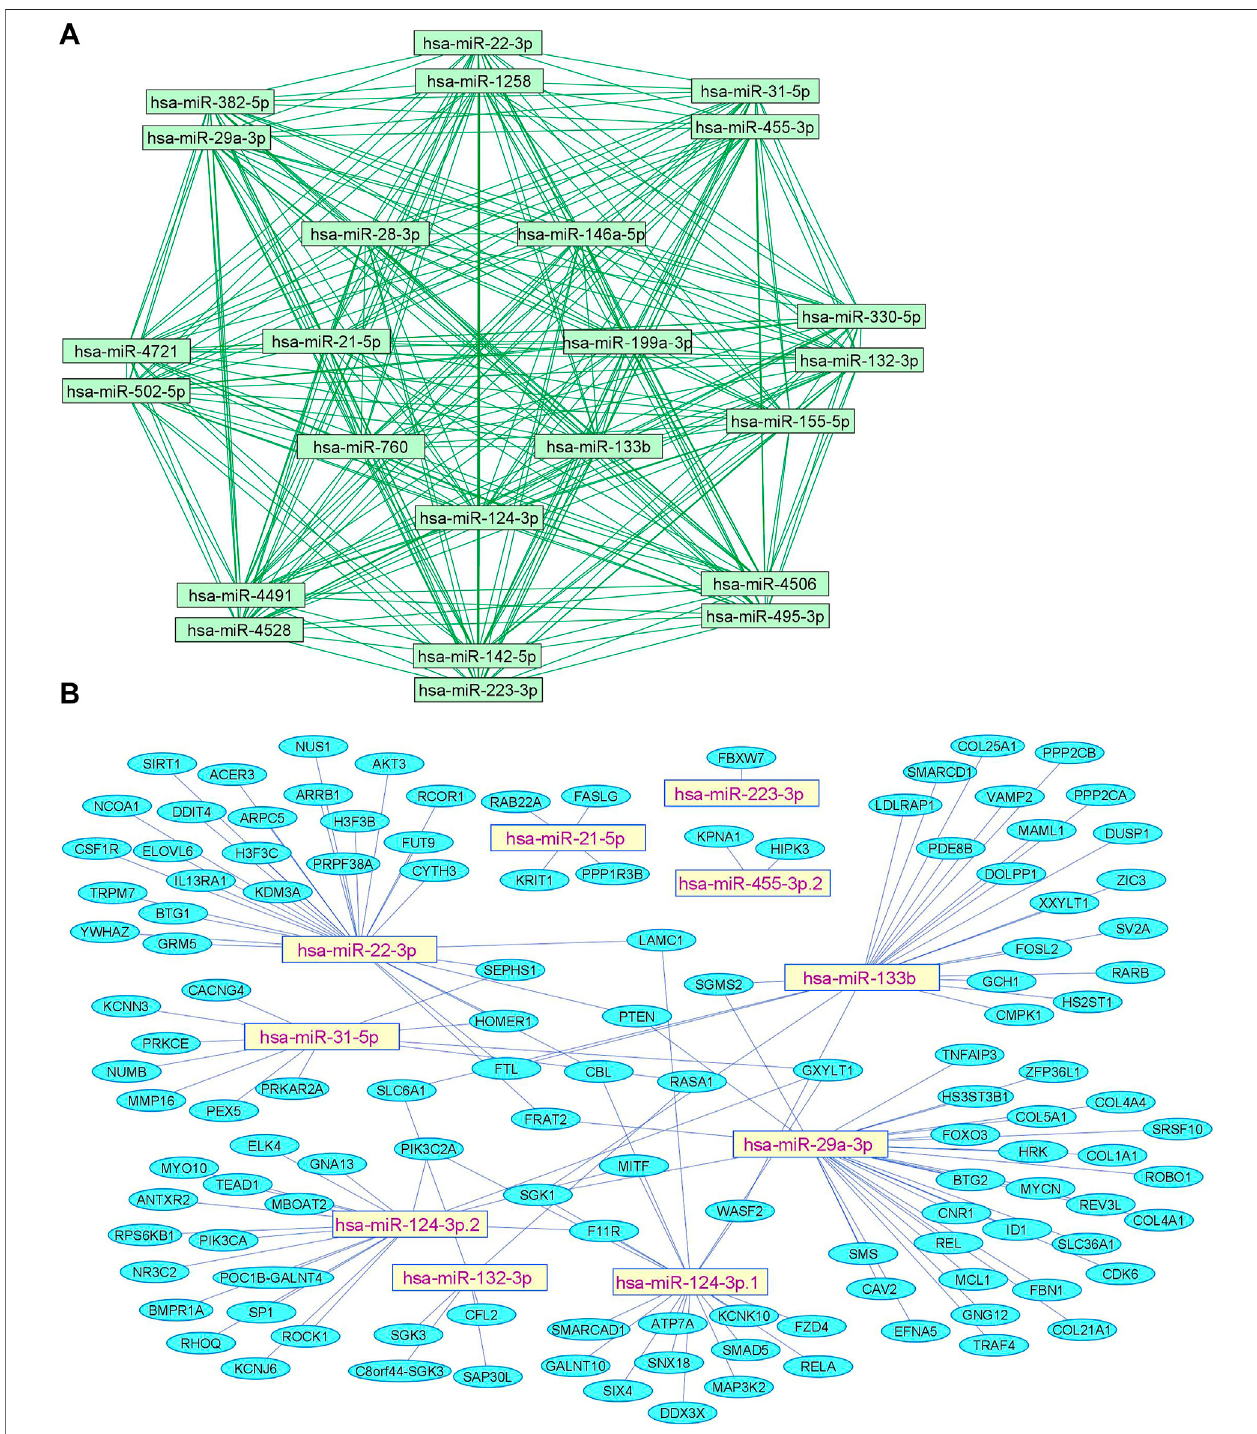
FIGURE1 | Upregulated human microRNA networks in neuropathic pain: (A) Human microRNA – microRNA network: Human miRNA-miRNA interaction network with 24 nodes and 276 edges. The networks were constructed using Cytoscape 3.8.2. (B) Human microRNA – gene target network: Architecture of networks of upregulated miRNAs in humans implicated in neuropathic pain showing interaction network of functionally enriched miRNAs with their targets with 137 nodes and 145 edges.ThenetworkswereconstructedusingCytoscape3.8.2.UsingMienturnet,themiRNA-targetinteractionswereidenti fi edbyTargetScanandthefunctionally enriched miRNAs were generated using the KEGG